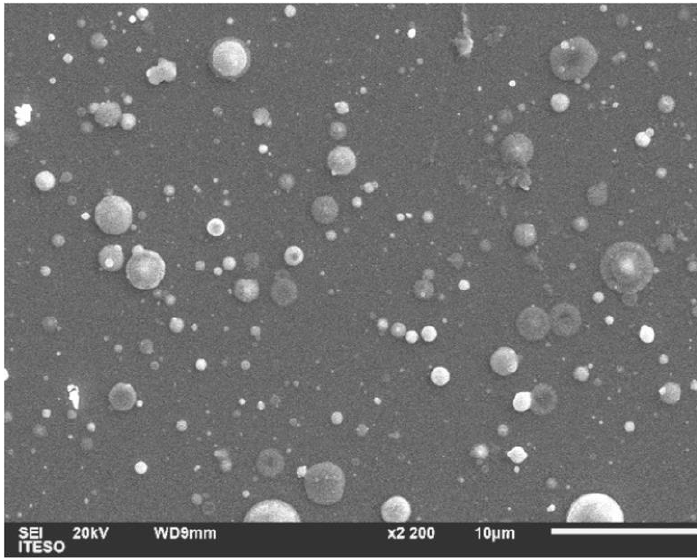
Figure 3. Scanning electron micrographs of Bi 2 Te 3 film deposited by PLD technique.